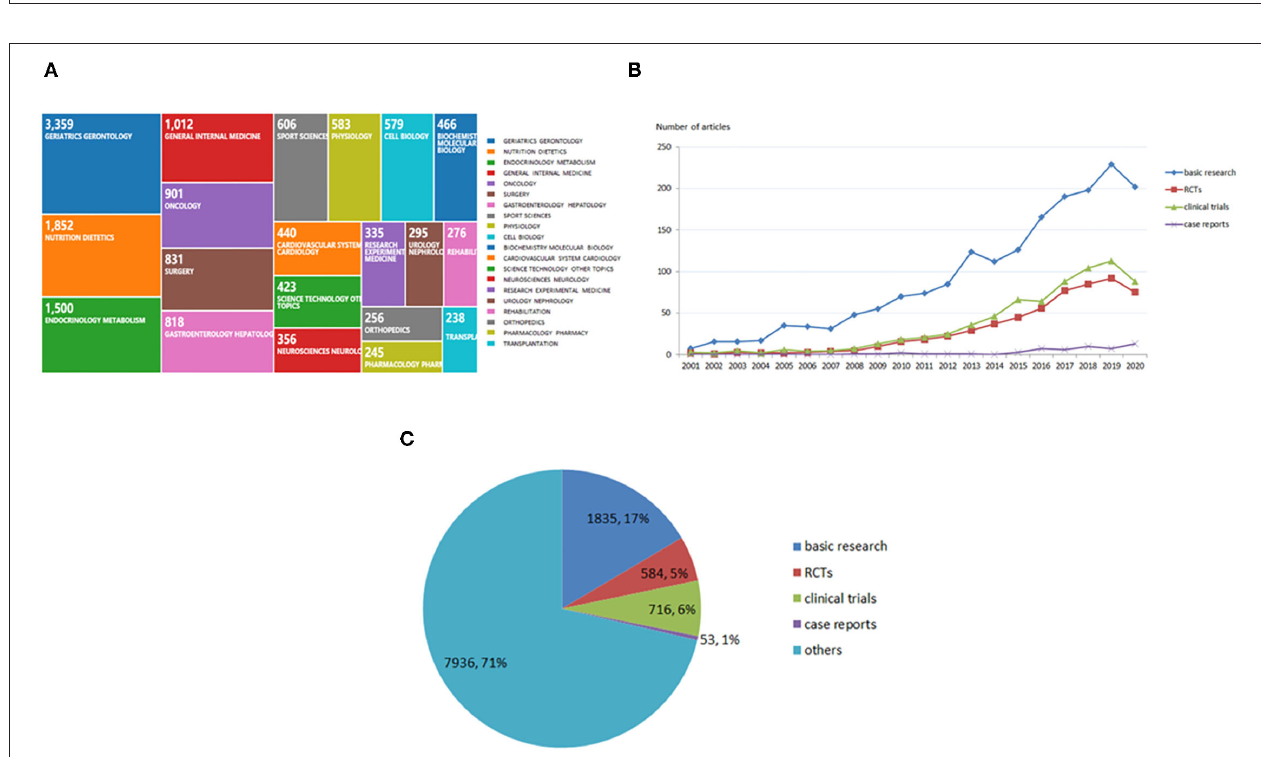
FIGURE 3 | Research area and article types globally. (A) Research area in global sarcopenia research. (B) Randomized controlled trials, clinical trials, case reports, and basic research worldwide from 2001 to 2020. (C) Percentage of various types of articles.